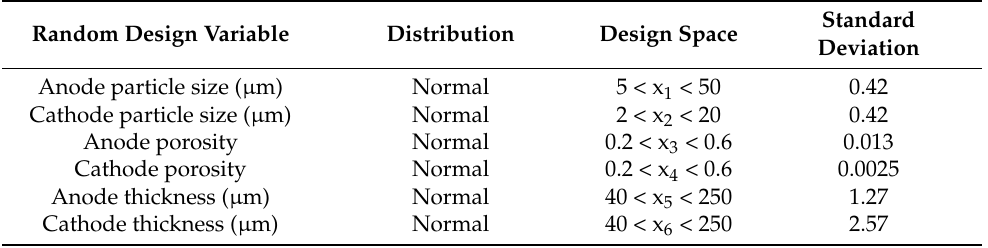
Table 2. Probabilistic distribution of design variables [14,15,19].